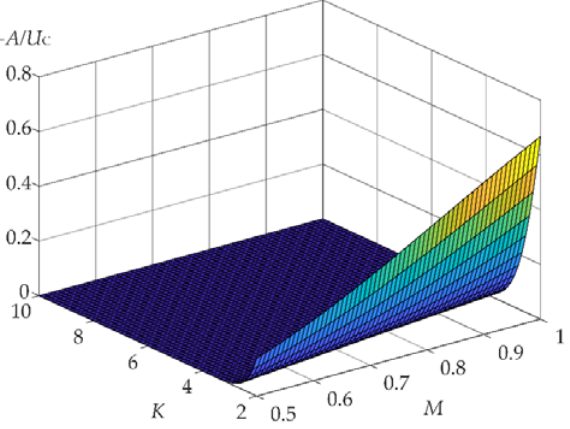
Figure 6. Amplitude of the additional fundamental component with varied modulation index M and carrier ratio K .